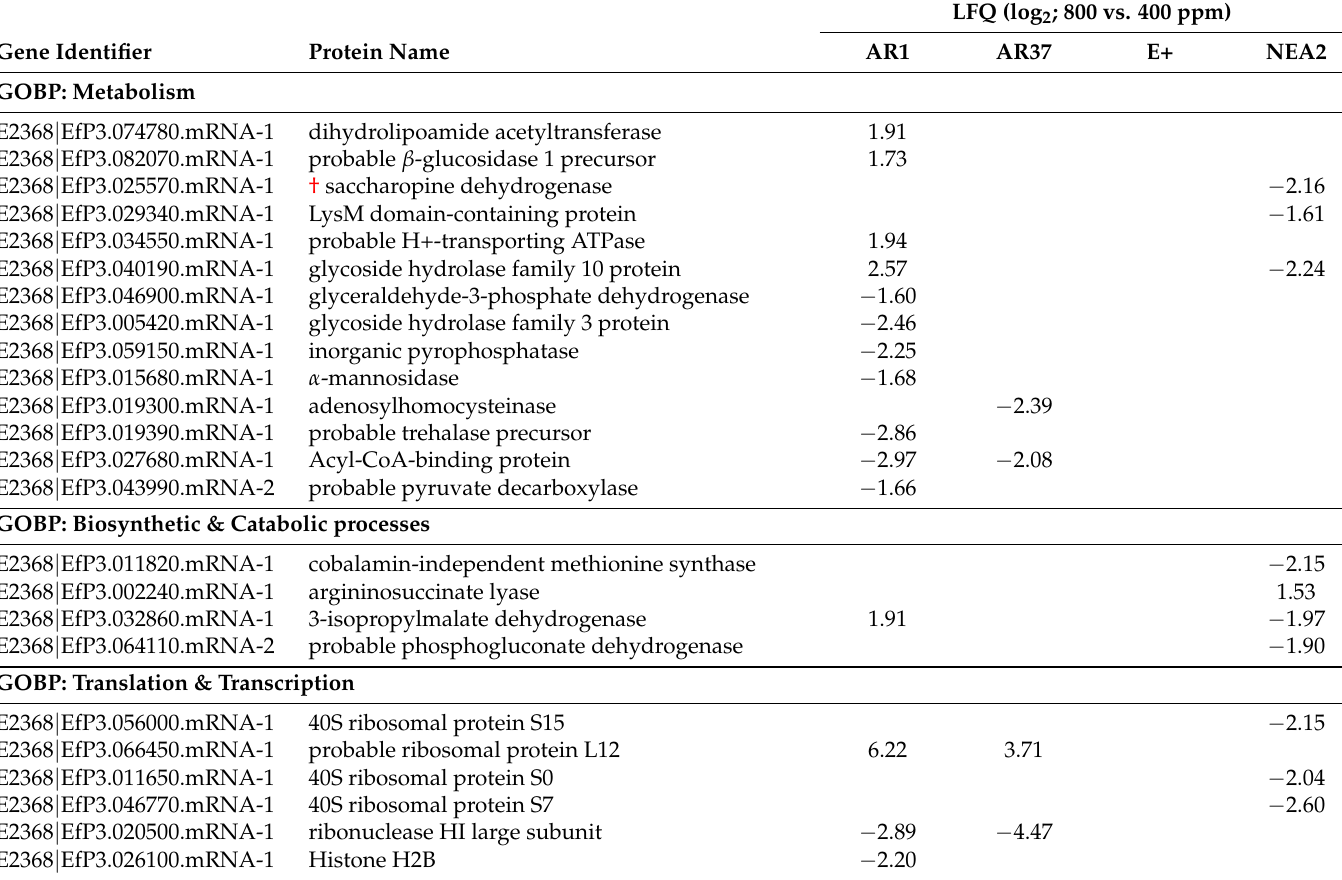
Table A3. Differences in fungal proteins identified by quantitative proteomics profiling influenced by rising CO 2 levels. Proteins that load heavily in the proteome PCA are denoted with a †, see Table A2. Proteins that load heavily in the integrated OMICs PCA are denoted with a (cid:88)